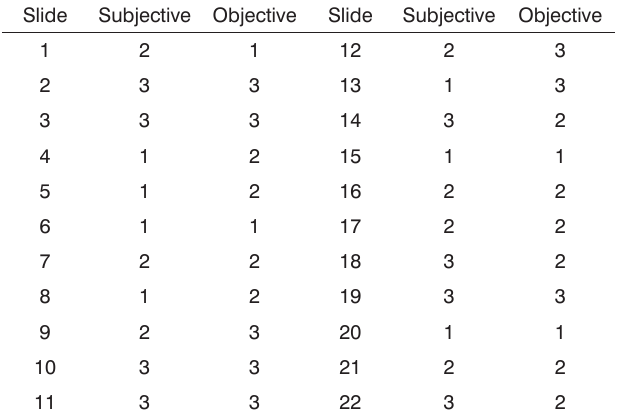
Table 4. Comparison between subjective and objective assessments of those in group